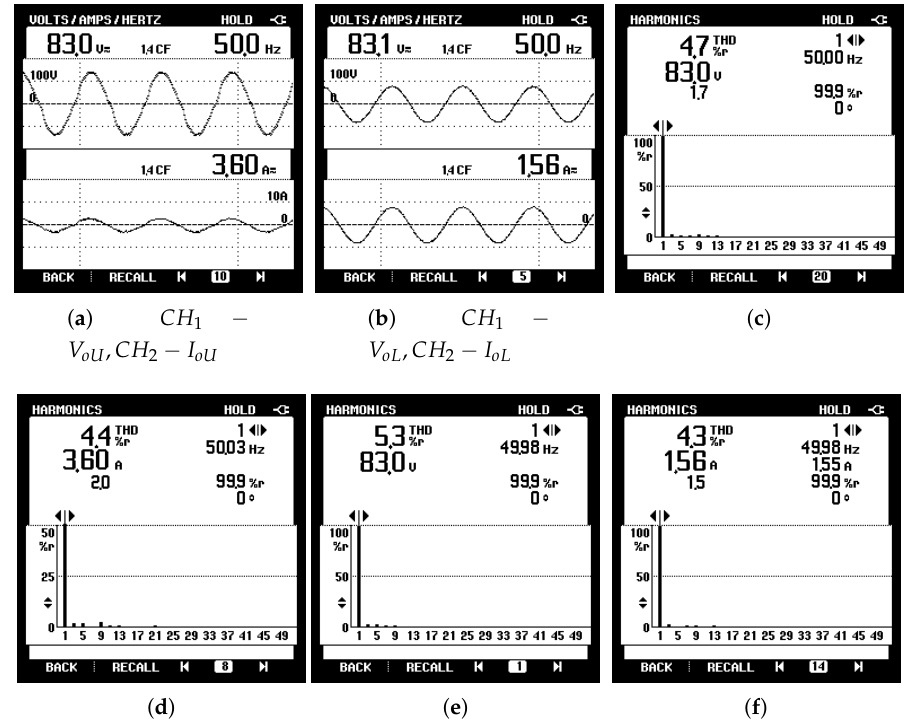
Figure 8. Prototype Results: ( a ) Upper output voltage and load current, ( b ) Lower output voltage and load current, ( c ) Upper output voltage THD, ( d ) Lower output voltage THD, ( e ) Upper Current THD, ( f ) Lower Current THD.